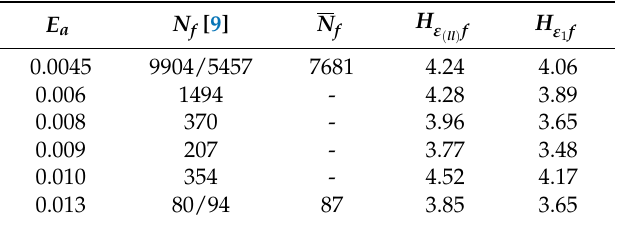
H ε and f ll )( and H ε ( ll ) f ε 1 f